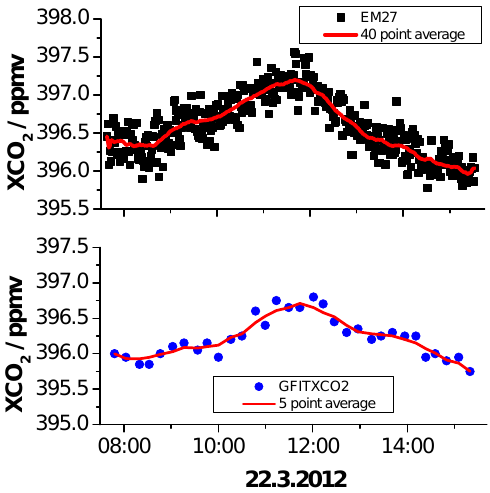
Fig. 12. Sample day to derive the XCO 2 noise of the EM27 and GFIT(TCCON) values. When taking into account the different recording durations, the noise level is comparable. The number of interferograms and respective recording time contained in a single EM27 datapoint are 10 IFGs and 34s, for a single GFIT datapoint 4 IFGs and